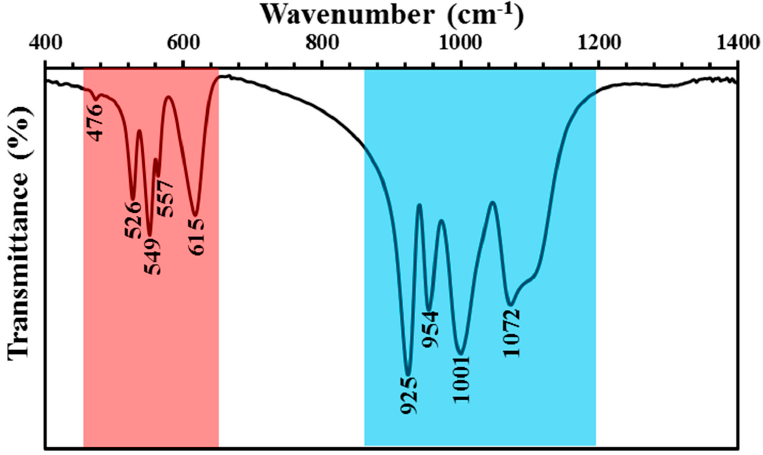
Figure 4. FT-IR spectroscopy of BiP-500: vibrational bands and wavenumbers in cm − 1 .